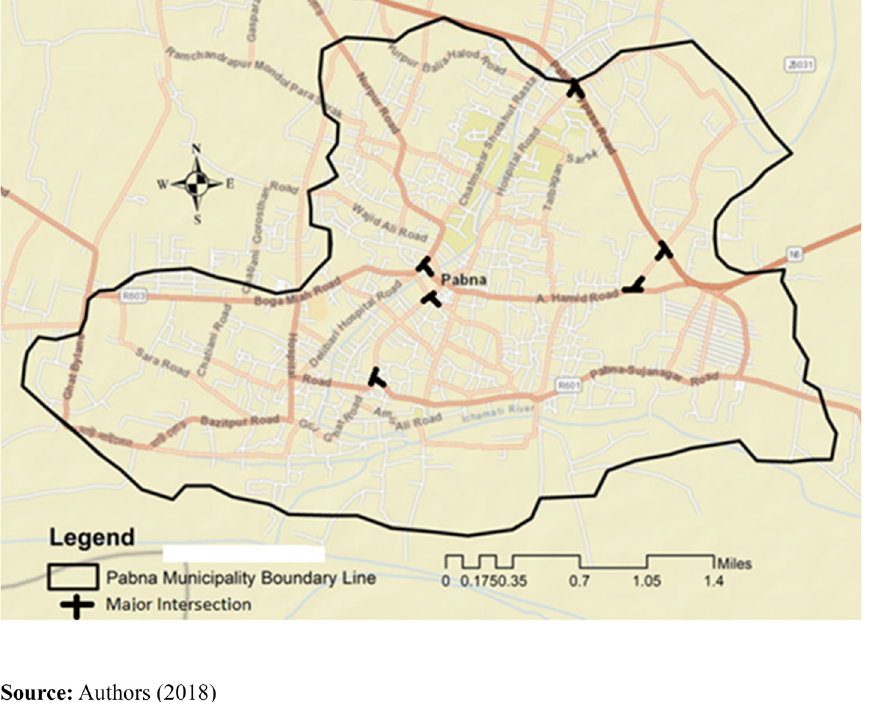
Figure 2. Survey location of